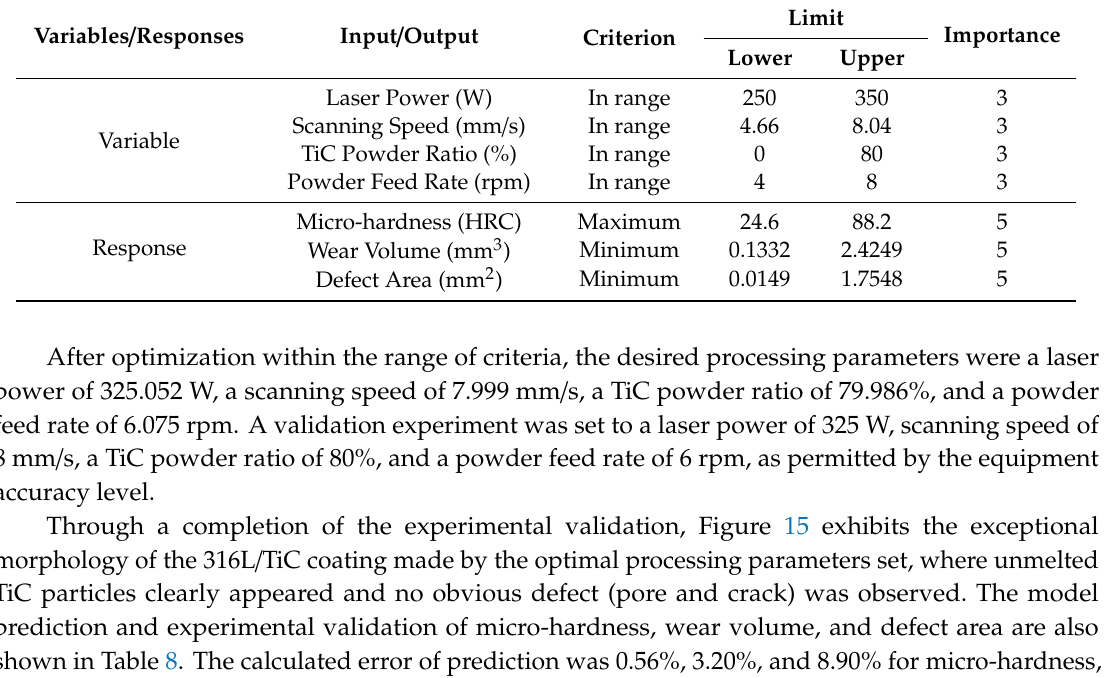
Table 7. Optimization criteria and targets.